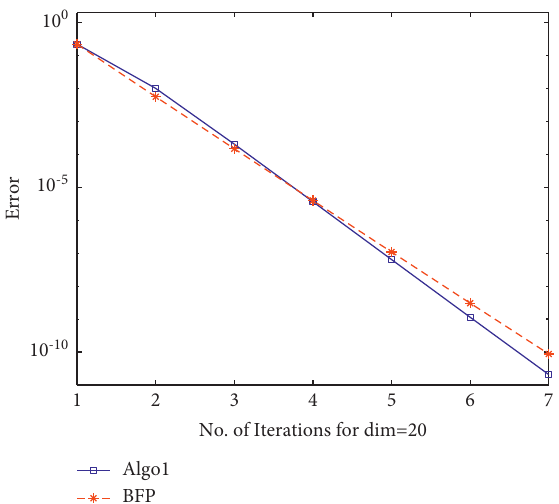
Figure 18: Iteration no. vs error for dimension 20.